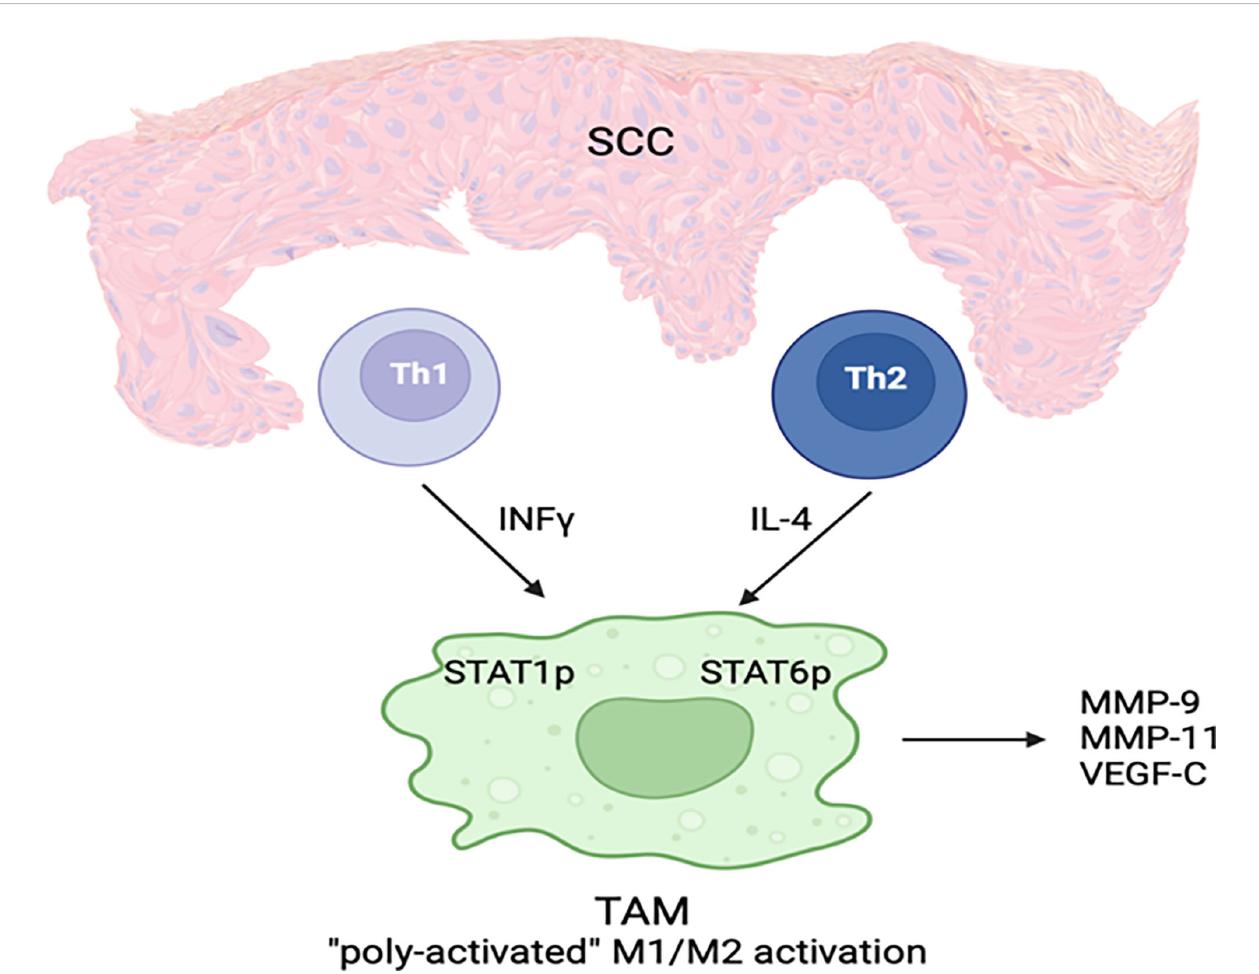
FIGURE 2 A subset of TAMs in cSCC displays both classical and alternative activation features simultaneously. IFN- g and IL-4 are secreted by Th1 and Th2 cells, respectively, in the cSCC microenvironment. As a result of these cytokines, which activate M1 classic and M2 alternate phenotypes, poly-activated TAMs are generated. STAT1 and STAT6 phosphorylation as well as MMP-9, MMP-11, and VEGF-C expression are characteristic features of